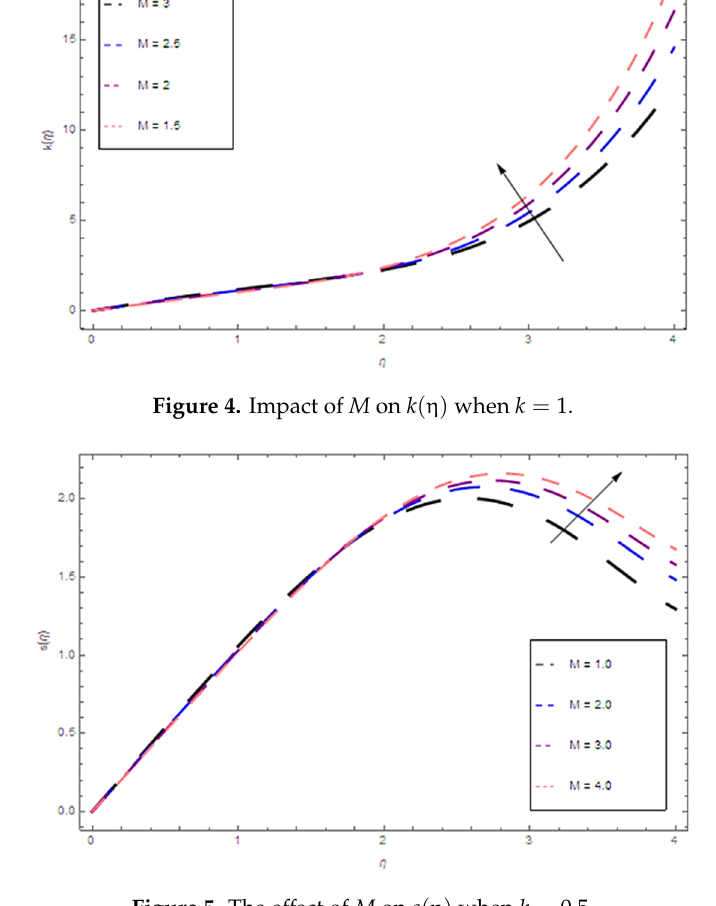
Figure 5. The e ff ect of M on s ( η ) when k = 0.5. Figure 5. The effect of M on ( ) s  when 0.5 k  . Figure 5. The effect of M on ( ) s  when 0.5 k  . Figure 5. The effect of M on ( ) s  when 0.5 k  .